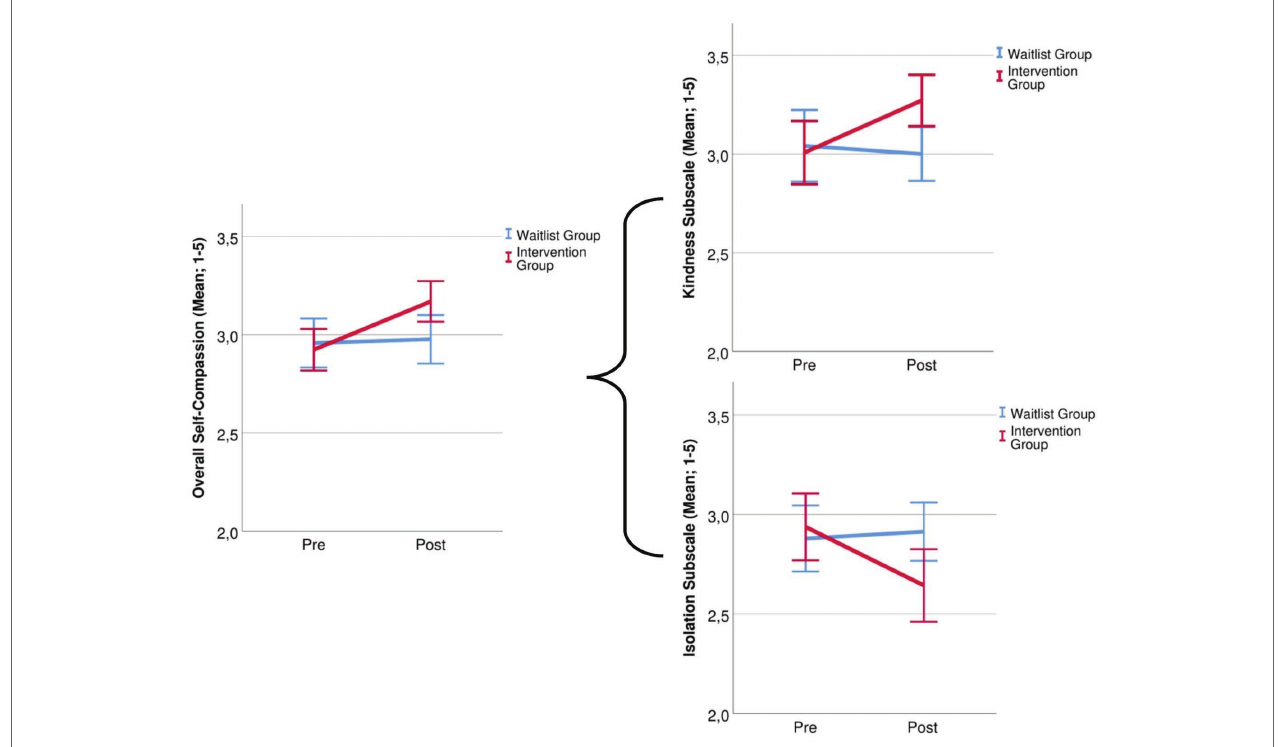
FIGURE 2 | Group changes in overall self-compassion and for the subscales self-kindness and isolation before and after the 14-day